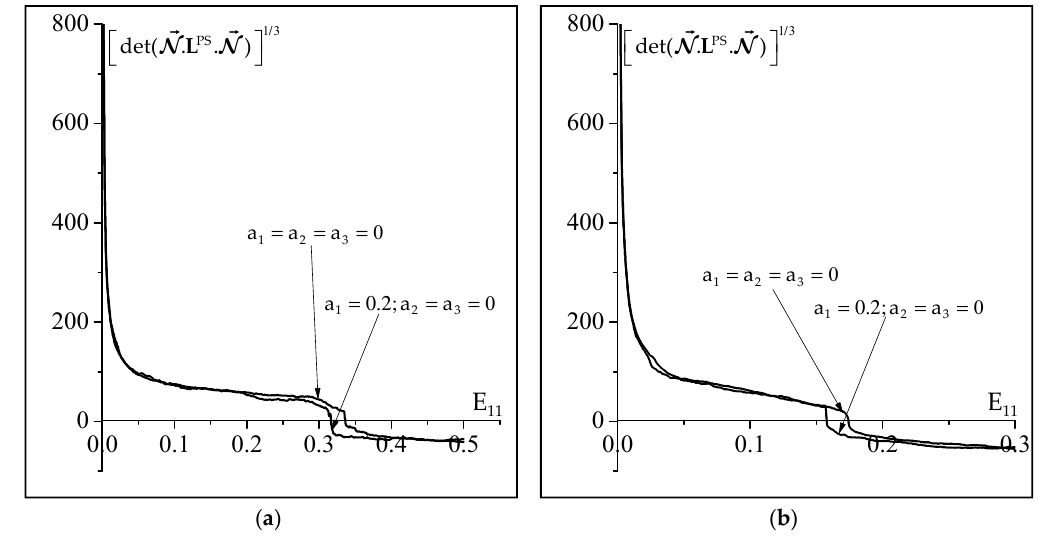
Figure 5. Impact of the non-Schmid effects on the evolution of the minimum of the determinant of the acoustic tensor as a function of E 11 : ( a ) Uniaxial tensile state ( ρ = − 0.5 ); ( b ) Plane-strain state ( ρ = 0 ) .